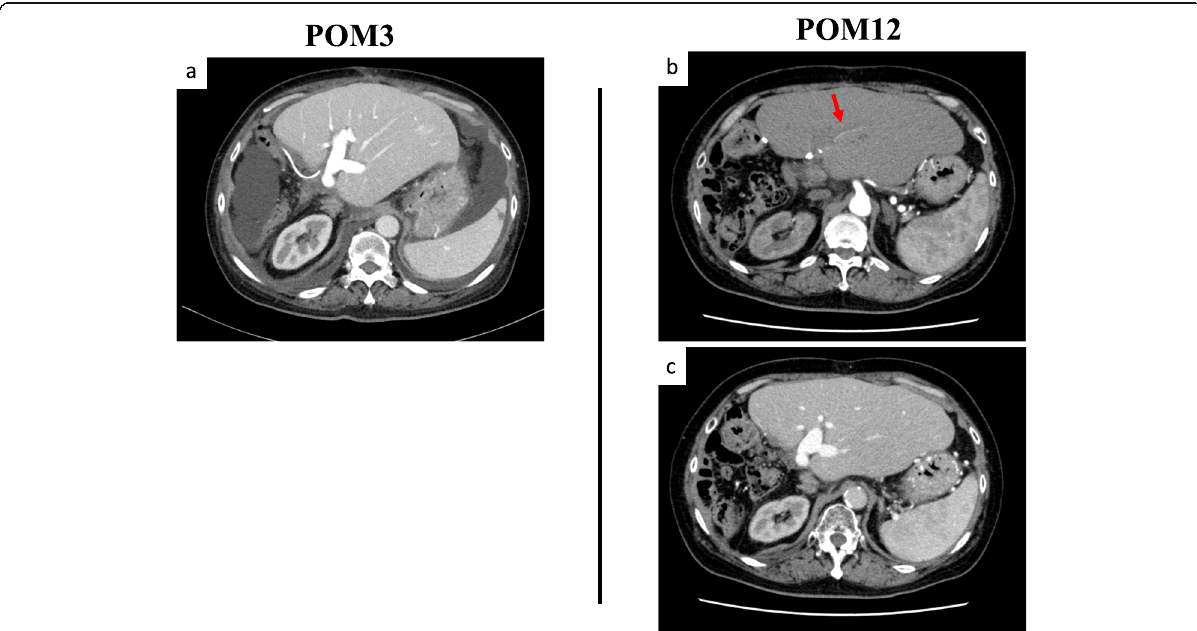
Fig. 3 a CT scan performed on POM 3 showing that the portal vein was enhanced through the ileal arteriovenous shunt at the arterial phase. b CT scan performed on POM 12 showing that a thin hepatic artery (arrow), which indicated improved arterialization through bile duct anastomosis, was visible during the early arterial contrast phase. c The portal vein was enhanced through the ileal arteriovenous shunt on the late arterial